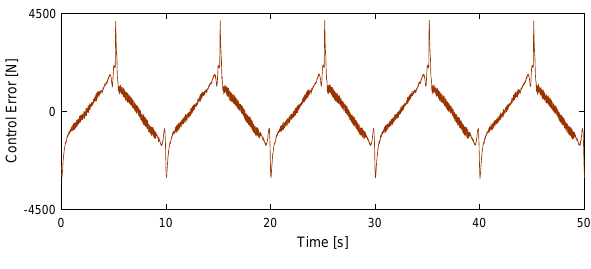
Figure 13: Performance in the presence of velocity dis- turbance using feedback.